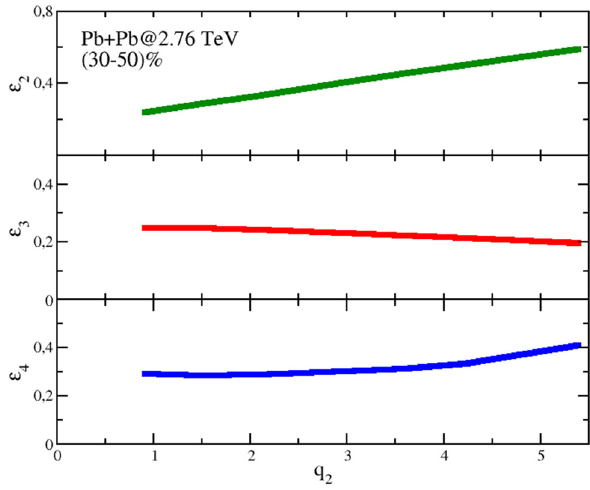
Fig. 3 Different order spatial eccentricities (cid:11) n = 2 , 3 , 4 as a function of √ s NN = 2 . 76 TeV PbPb collisions reduced flow vector q 2 for